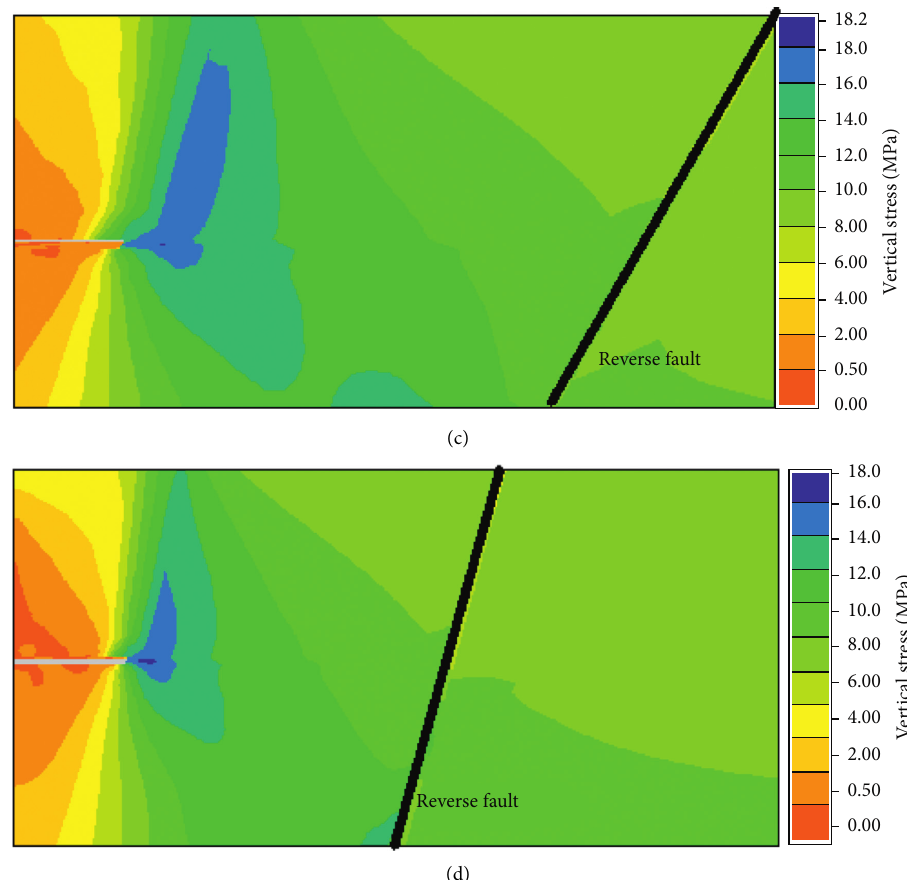
Figure 8: Stress distribution when the distance between working face and reverse fault is 70m with different dip angles. (a) The dip angle of reverse fault is 30 ° . (b) The dip angle of reverse fault is 45 ° . (c) The dip angle of reverse fault is 60 ° . (d) The dip angle of reverse fault is 75 ° Table 2: Ratio of stress to initial stress when hanging wall working face is 35m away from monitoring point. Location of monitoring points